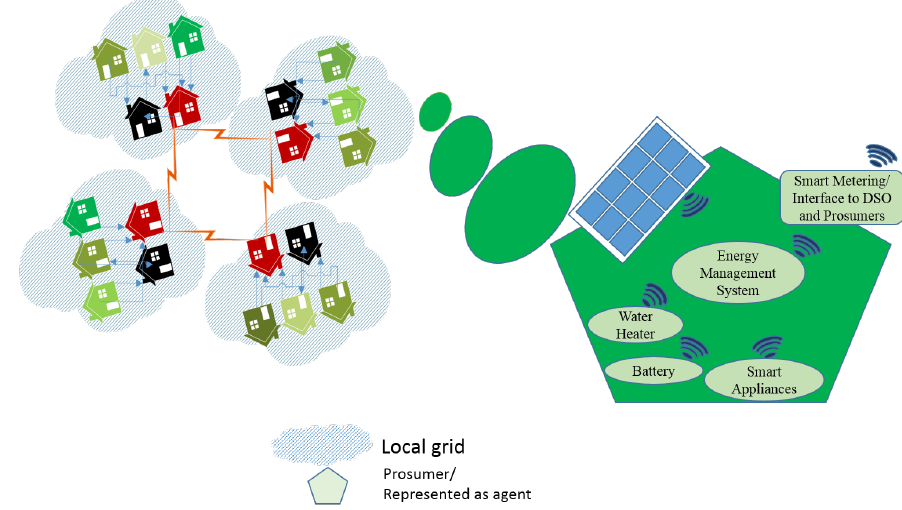
Figure 3. An example of multi-agent system interaction (adapted from